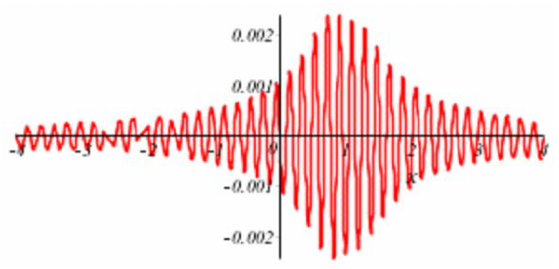
Figure 2. Error function of the Hermite series approximation up to 40 terms with Dominici approximation in the next 460